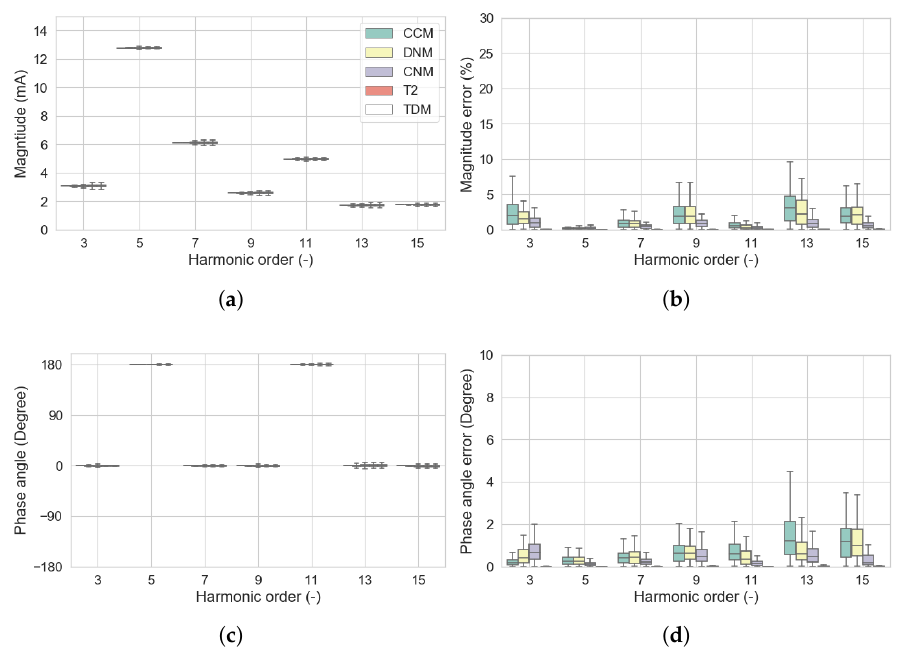
Figure 15. Comparison of the Type C LED lamp frequency domain models for flat-top voltage supply: ( a ) Magnitude; ( b ) Magnitude error; ( c ) Phase angle; and ( d ) Phase angle error.